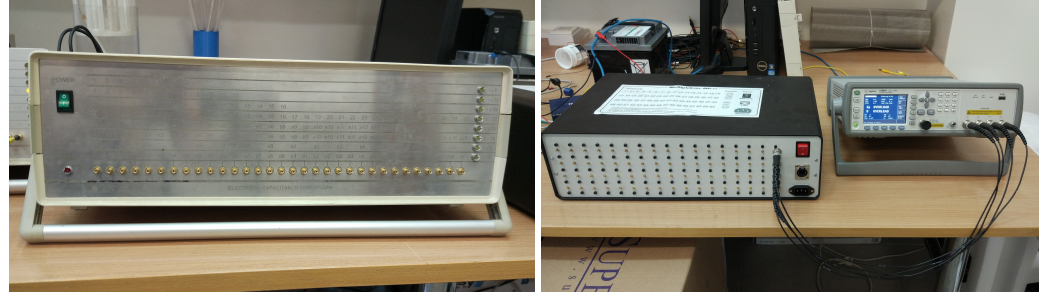
Figure 3. Experimental setup hardware: left—32-channel ET3 measurement hardware, right—Agilent E4980A with 64-channel multiplexer device.